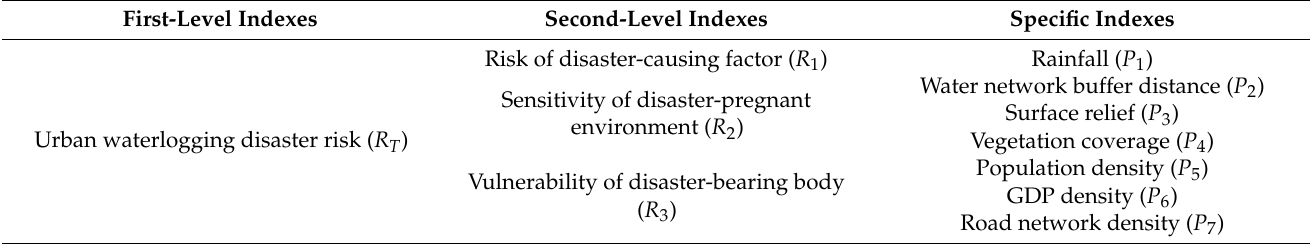
Table 2. Risk assessment index system for urban waterlogging